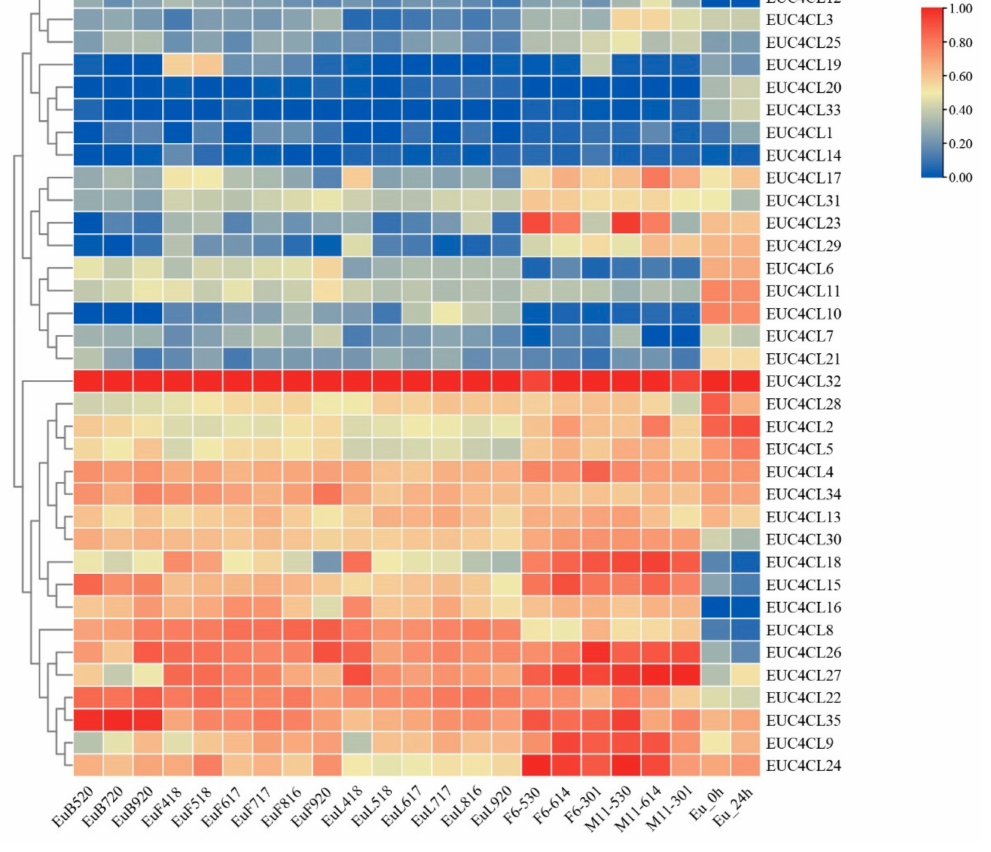
Figure 5. Expression profiles of Eu4CL genes during the development of flowers and roots under salt